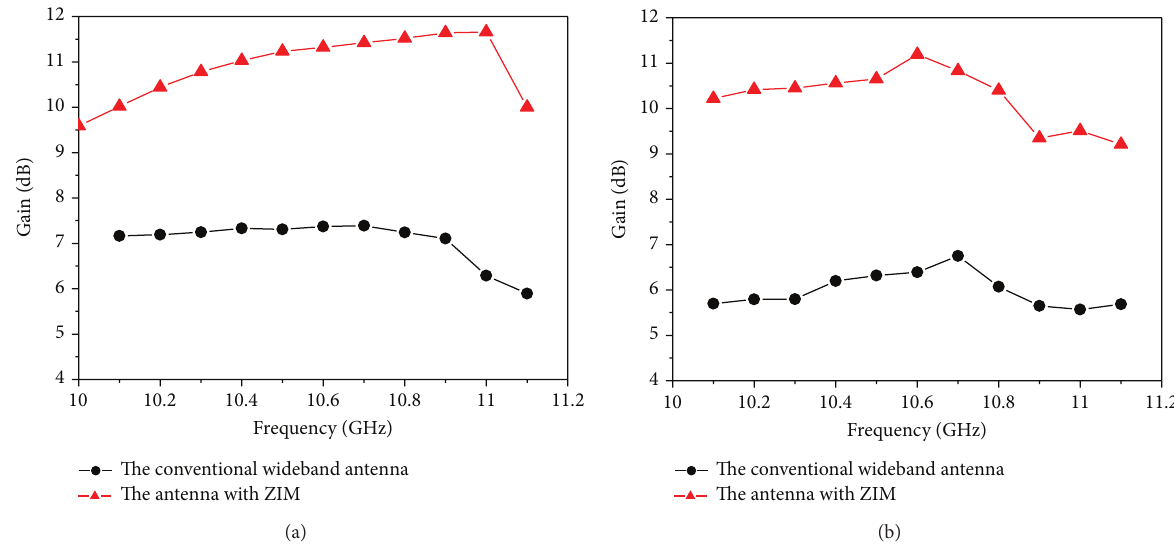
Figure 12: The comparative gains of the conventional wideband antenna and the proposed antenna, (a) simulations and (b) measurements.